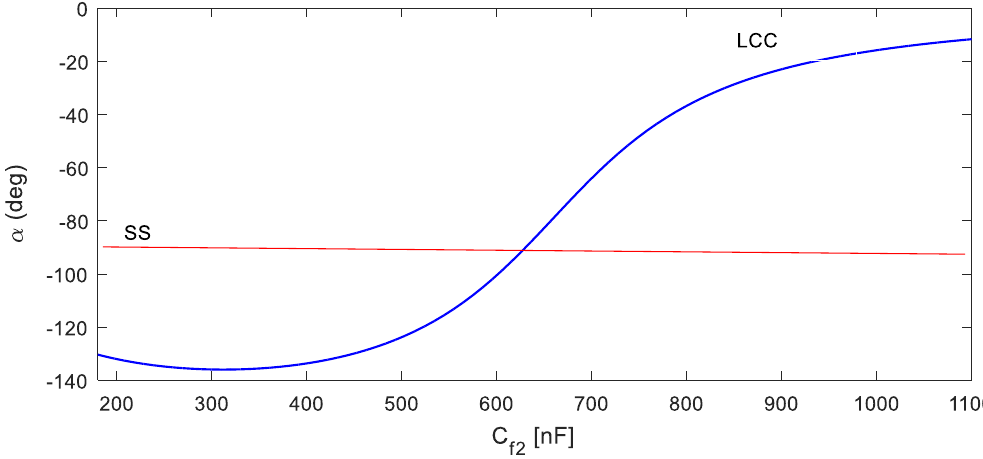
Figure 9. Coil currents distribution using SS and LCC compensations varying C f 2 .